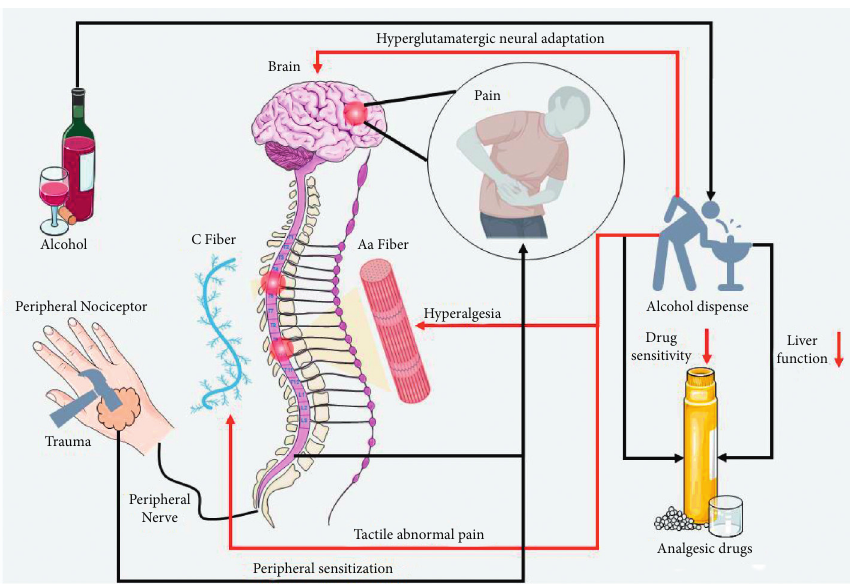
Figure 1: Alcohol and pain mechanisms.